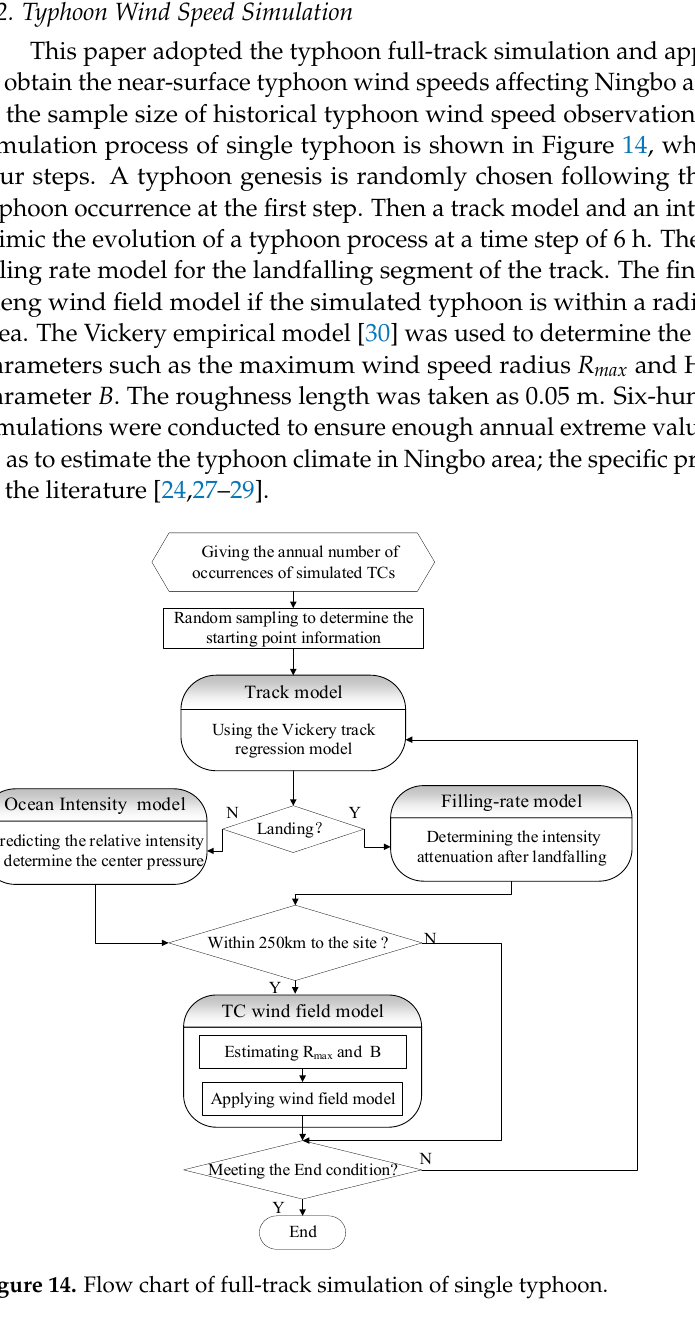
Figure 14. Flow chart of full-track simulation of single typhoon.